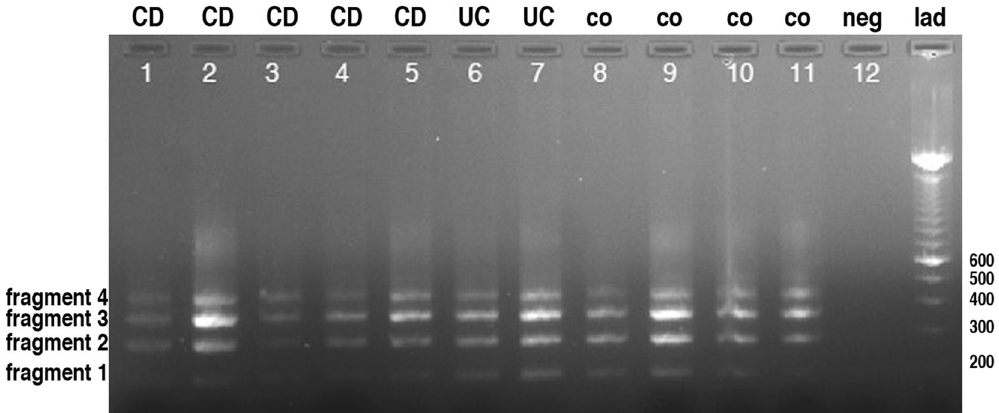
Figure 3. Periostin isoforms in the colonic tissue. The gel shows the isoforms present in tissue biopsies of CD patients (lanes 1–5), UC patient (lanes 6–7) and non-IBD controls (lanes 8–11). Lane 12 shows the negative control. Please note that there are minor fluctuations between the intensities of the different fragments that do not show any correlation between diseases CD (1–5) or UC (6–7), or controls (8–11). Fragment 1 (188 bp) is just below the 200 bp marker while fragment 4 (452 bp) is between 400 and 500 bp.